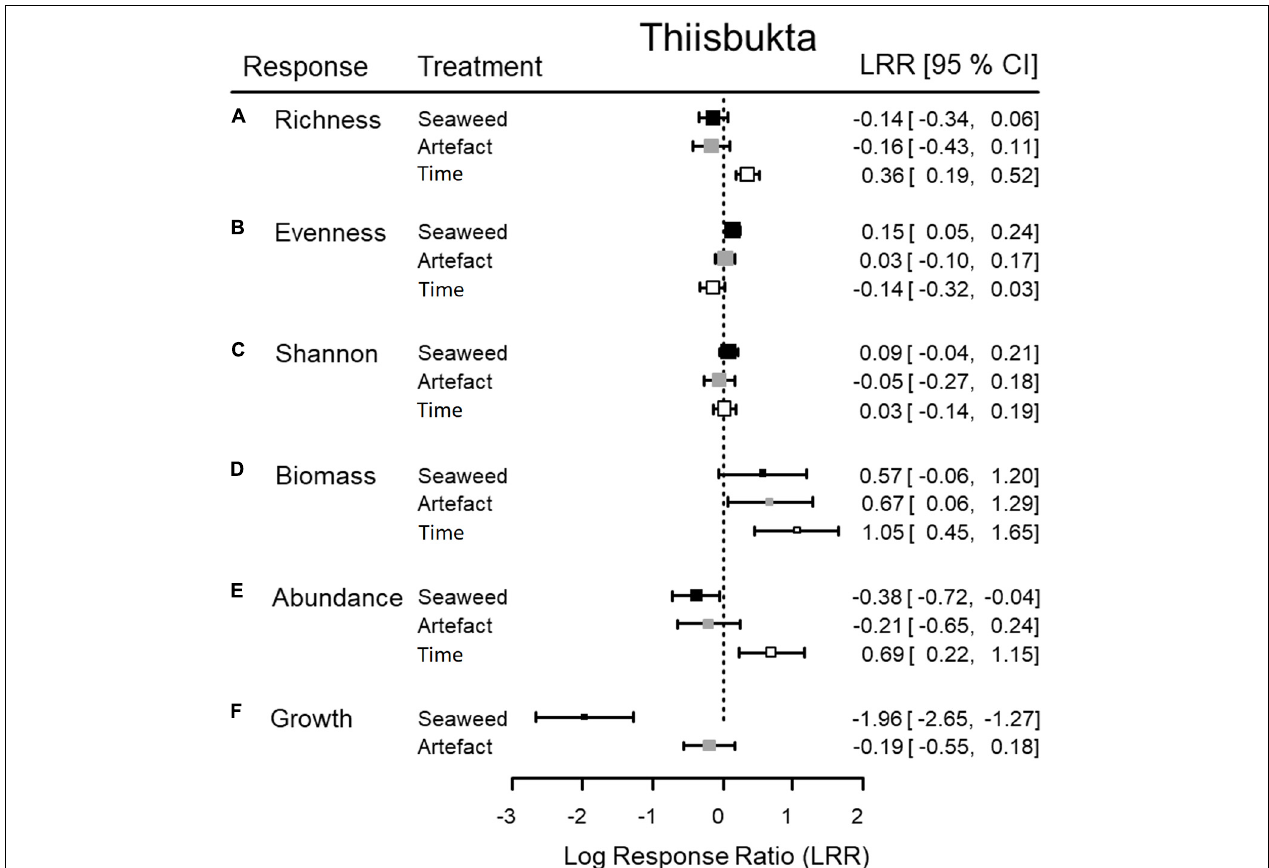
FIGURE 5 | Thiisbukta. Mean (square) and 95% confidence interval (horizontal whiskers) of logarithmic effect ratios (LRR) to quantify the effect of (i) seaweed presence (“Seaweed”; seaweed-covered vs. unmanipulated, black), (ii) procedural controls (“Artifact”; empty net-covered vs. unmanipulated, gray), and (iii) changes in unmanipulated areas over the course of the experiment (“Time”; unmanipulated end vs. unmanipulated start, white), for six (A–F) responses. Dashed line = level of no effect, n =